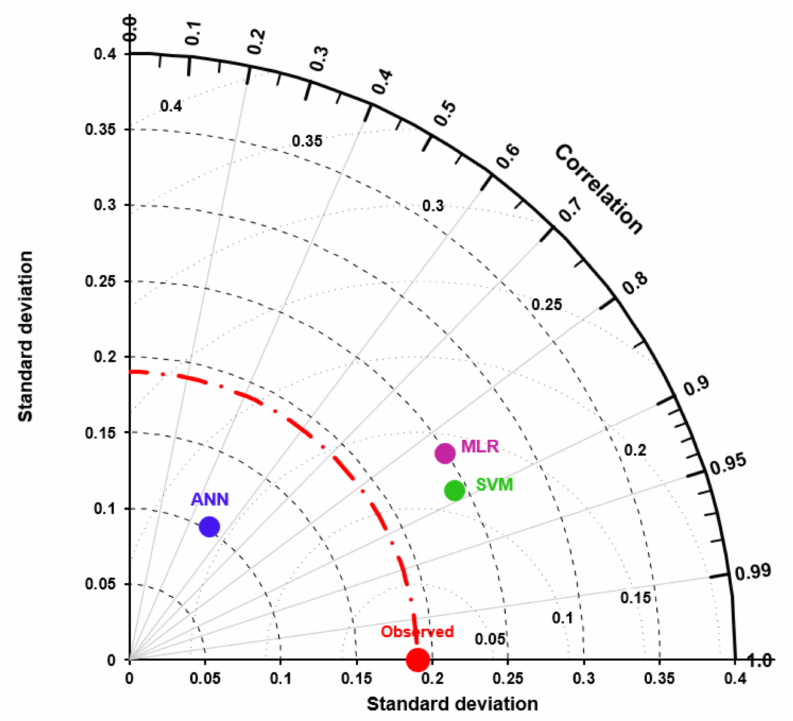
Figure 6. Taylor diagram of MLR, ANN, and SVM corresponding to observed grain velocity (V p